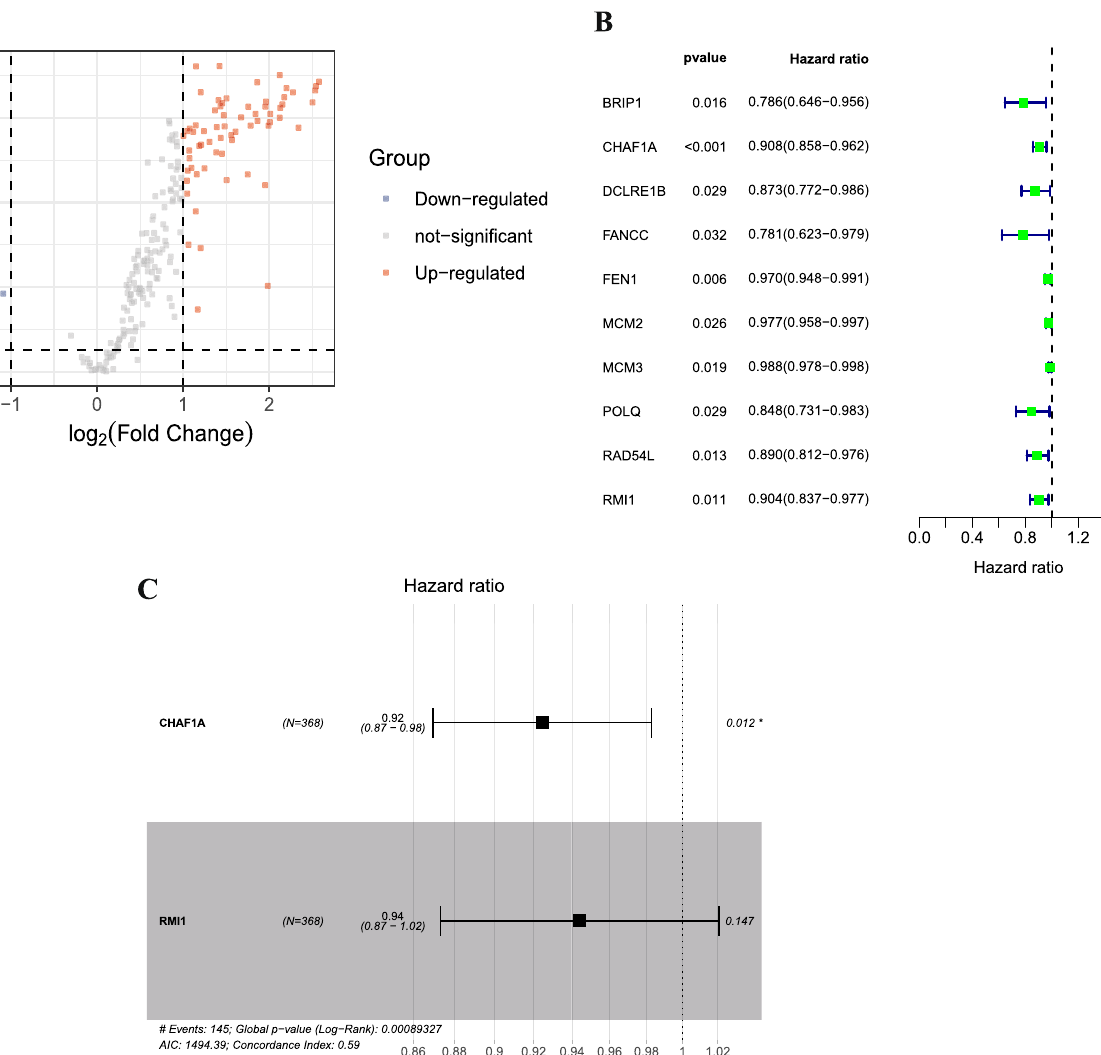
Figure 1. Prognostic DNA repair genes identification and signature construction in the TCGA cohort. ( A ) The volcano plot of the differentially expressed genes between GC and normal samples; ( B ) Univariate Cox regression analysis identifying prognostic variables with HR with 95% CI and P values; ( C ) Prognostic signature construction using multivariate Cox regression patients deaths elevated. A chi-squared test revealed that the mortality rate of the high-risk group was significant high than that in the low-risk groups (46.7 vs 32.1%, P = 0.004). Similar results were observed in the validation cohort (Fig. 3C-D). In GSE66229 cohort, the AUC was 0.623 and survival analysis revealed a favorable perfor- mance of the signature for stratifying high-risk and low-risk patients. The mortality rate of the high-risk group